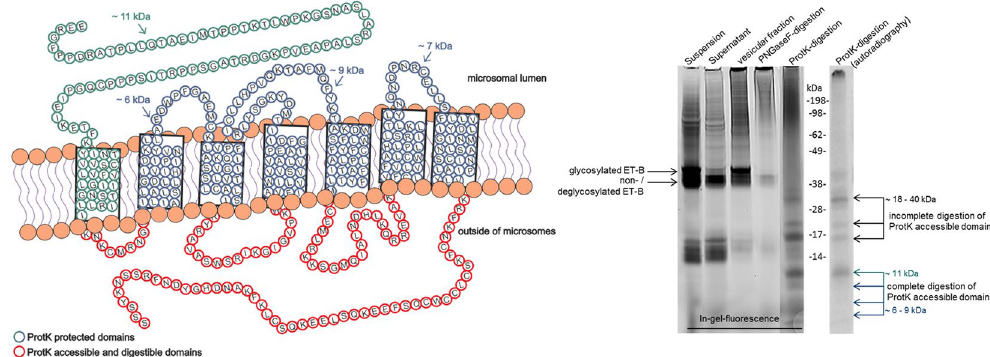
Figure 3. Schematic illustration of the ET-B receptor embedded in microsomal membranes and comparison of in-gel-fluorescence and autoradiographic analysis of the synthesized ET-B receptor. Left panel: Shown in red are proteinase K accessible domains that will probably be digested by the enzyme. Proteinase K protected domains are colored in green and blue. Right panel: ET-B was synthesized in the presence of a precharged tRNA harbouring the fluorescence dye Bodipy, coupled to lysine. Bodipy was used to visualize protein bands as alternative to radioactively labeled leucine bands. PNGaseF and ProtK-digestion were performed with the vesicular fraction. Green and blue arrows indicate the corresponding bands to the illustrated domains in the left panel. Black arrows indicate upper bands that might result of incompletely digested domains outside of the microsomal